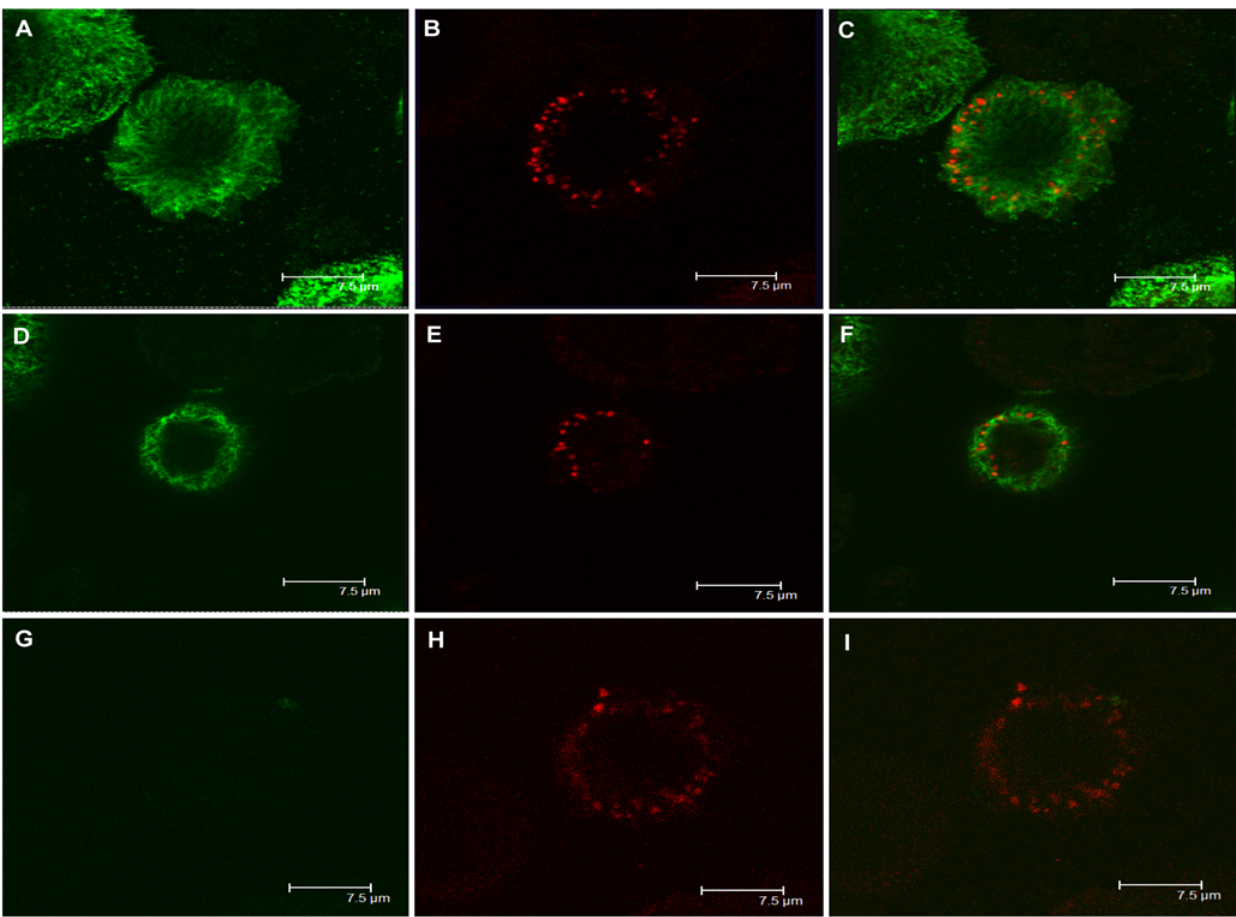
Figure 5. Confocal microscopic examination revealing association of KSHV viral particles with microtubules. BCBL-1 cells induced with TPA for 48 hours were fixed, permeablized, and stained with mouse monoclonal anti-tubulin a and rabbit-polyclonal anti-ORF65 antibodies, respectively. The secondary antibodies were anti-mouse IgG-Alexa Flour 488 (green) and anti-rabbit-IgG-Texas Red (red). The two channels were recorded sequentially and/or simultaneously and images acquired. The individually acquired MT (green channel) (A,D), viral particle (red channel) (B,E), and the merged images (C,F) of a cell are shown. The upper and middle rows represent two different optical sections at which images were acquired from a series of sections collected at 0.32 m m intervals from the bottom to the top of the image. IFA was also performed on BCBL-1 cells that had been treated with 5 m M of nocodazole and induced with TPA (the lower row). The individually acquired MT (G), viral capsid (H), and merged images (I) for a nocodazole-treated cell are